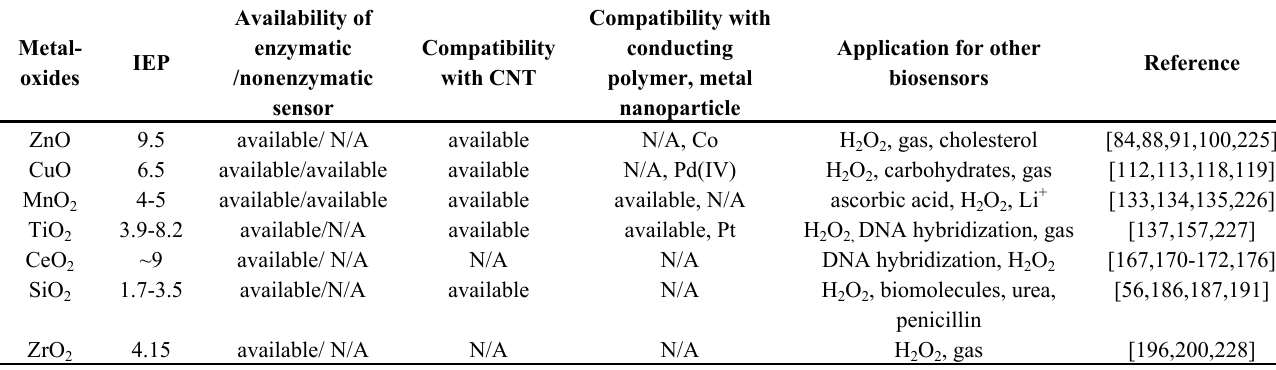
Table 2. Characteristics of most frequently-used metal oxides in prospective